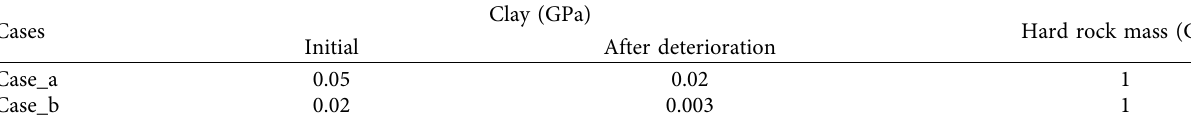
Table 2: Young’s modulus of hard rock mass and clay